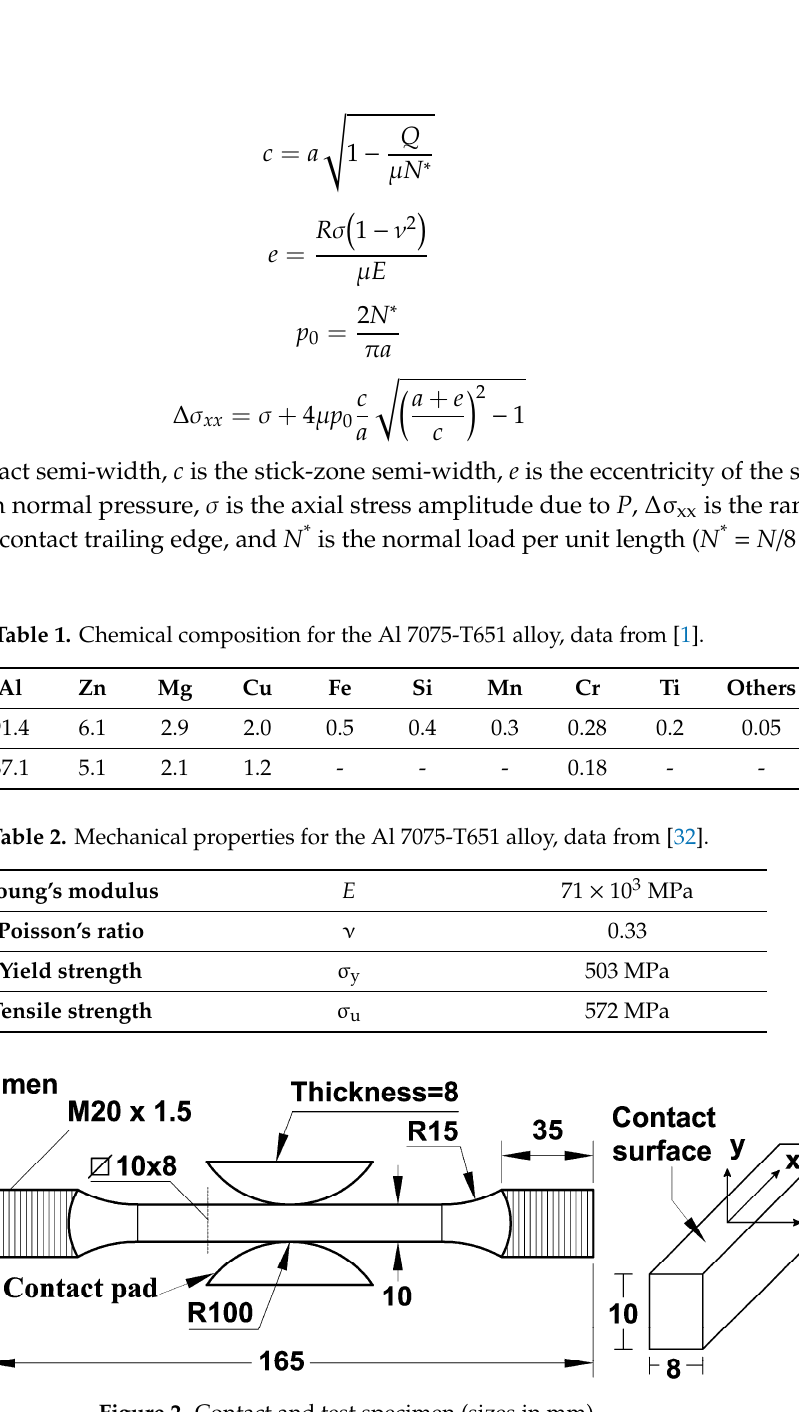
Figure 2. Contact and test specimen (sizes in mm).